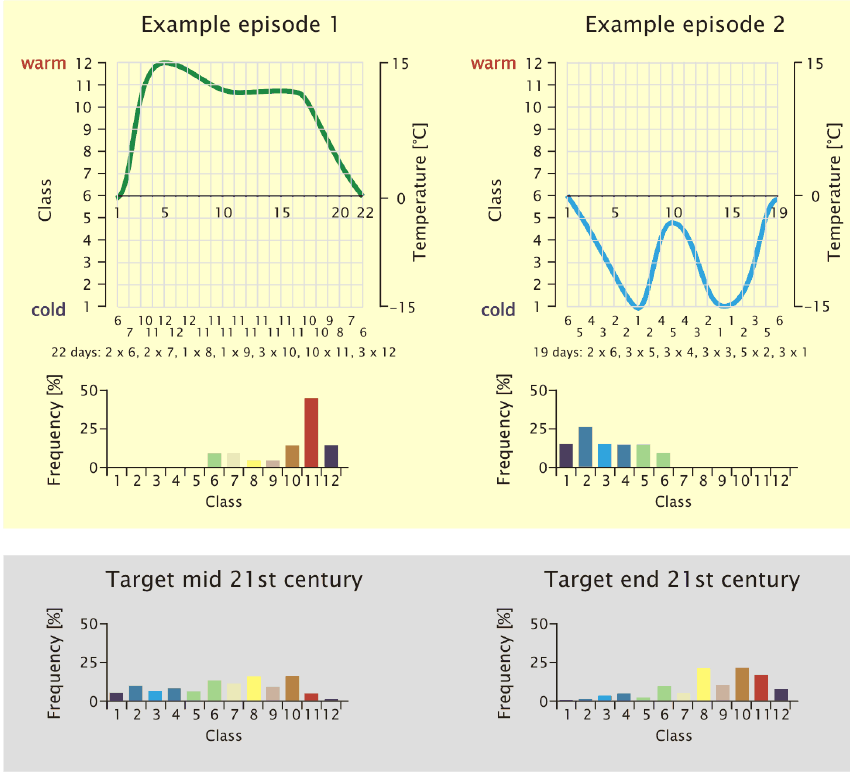
6. overlapping frequency distribution as a measure of dealing with seasonality (Section 3.6). Figure 6. Illustration of the building blocks and the prescribed frequency distributions that govern the selection/rejection criteria of the WG. The yellow-shaded part shows two sample episodes. The temperature axes indicate that the episode depicted left contains warm days (temperature average over the target area) and that the right episode contains cold days. Also shown is the assignment to the temperature-dependent circulation patters ( cf. Section 2.2). The rows of numbers underneath the curves denote the numbers of the patterns assigned to the respective days of the episodes, as well as frequency distributions for patterns 1...12 in both episodes. The bottom panel (gray shading) sketches the target distributions at the beginning (left) and the end (right) of the 21st century. They are needed in the synthesizing process described in the flow schematic in Section